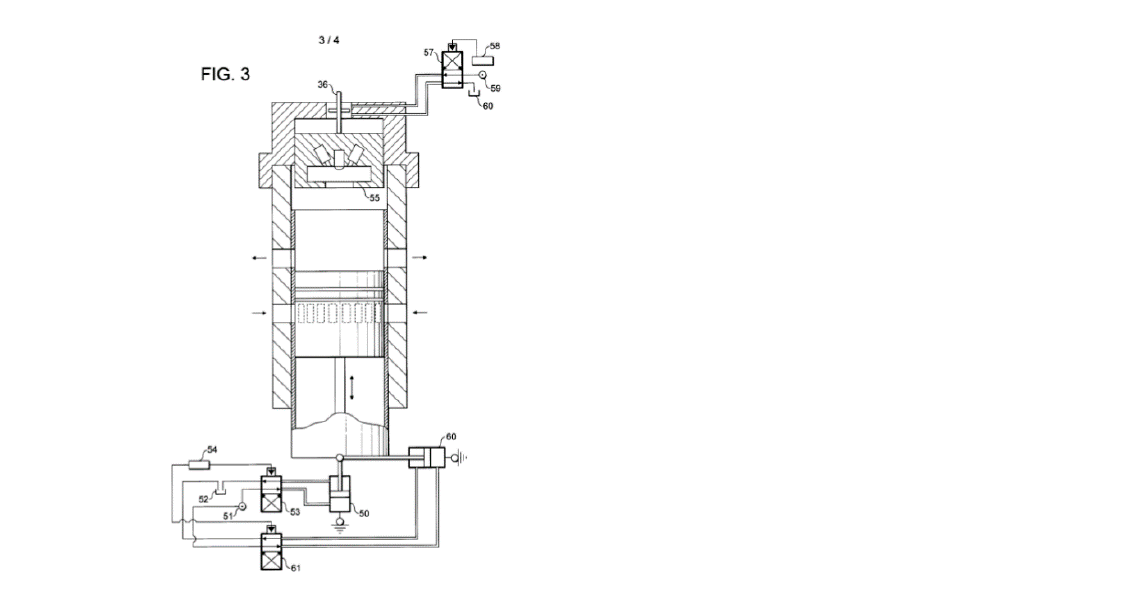
18 of 22 Figure 23. Pattakos December 2018 rotary sleeve valve for asymmetric timing in two strokes GB 2563685. Reproduced with permission from GB Patent Office Copyright Publisher, 2018. This is the last fully mechanical system found to date. The work of Turner et al. of Lotus [27] (Figure 24) where the sleeve motion is con- trolled via a yoke plate in one embodiment and electronic controlled hydraulic actuators in another. This allows both directions of motion of the sleeve to be driven and controlled independently of the crankshaft motion, allowing all three degrees of freedom in gas ex-